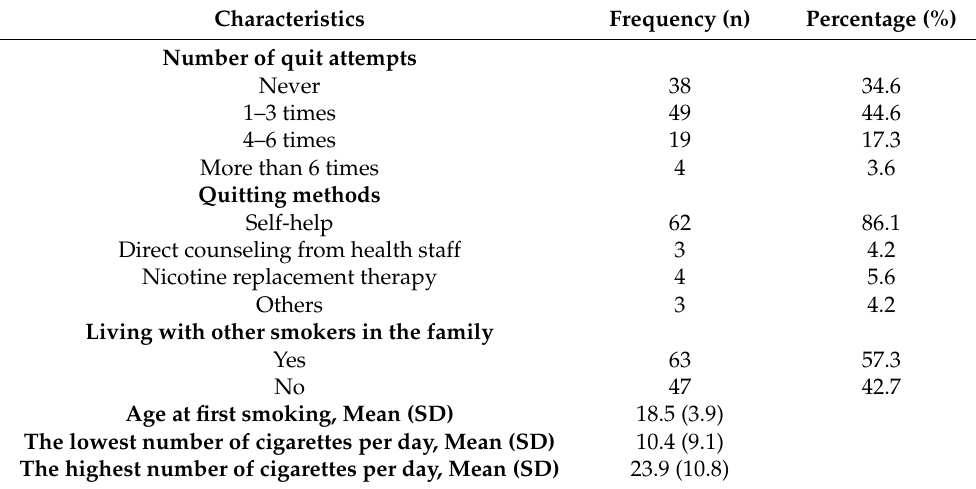
Table 2. Tobacco use and quit attempts before receiving counseling services.